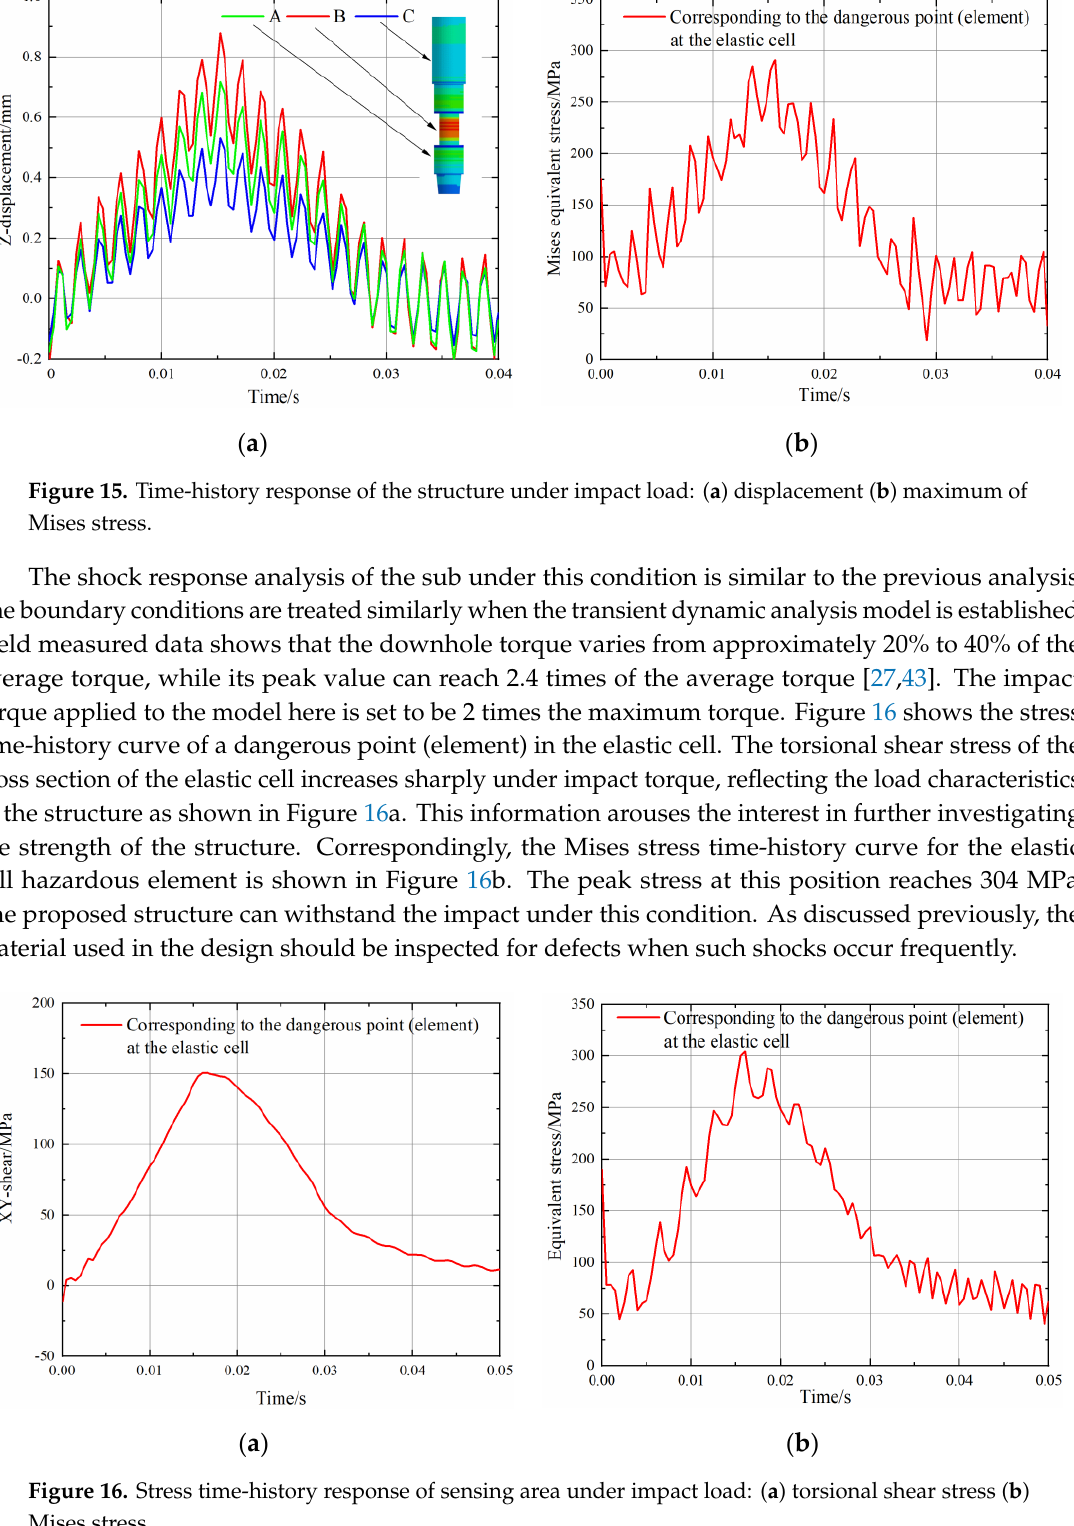
( c ) Figure 14. Stage results of the implicit-to-explicit sequential solution: ( a ) implicit solution result; ( b ) initialization model for explicit analysis; ( c ) explicit analysis result. To analyze the response characteristics of the sub under impact load, several time-history results are investigated. Figure 15 shows the displacement and the maximum Mises time-history curve of the structure. The overall trend of the curve is consistent with the load form. However, due to the high level of prestress in the structure, a certain oscillation occurs. The Z -direction (axial direction) displacement responses of the elements taken from three locations on the sub under impact load are shown in Figure 15a. The element B taken from the elastic cell part has a relatively large displacement. However, no significant displacement saltation occurred. This is mainly due to the stiffness assurance in the design. Figure 15b shows the time-history curve of the maximum Mises stress of the structure. The maximum value appears at the elastic cell part and reaches 291 MPa. This value is increased by approximately 40% compared to the extreme measurement